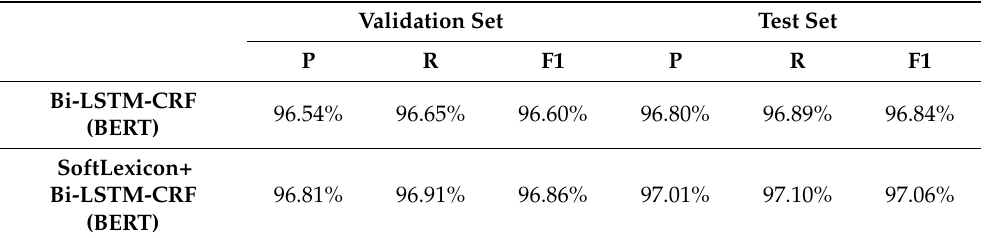
Table 4. Comparison between the SoftLexicon+Bi-LSTM-CRF and the Bi-LSTM-CRF on NLPCC2016 dataset. Both models use BERT to generate